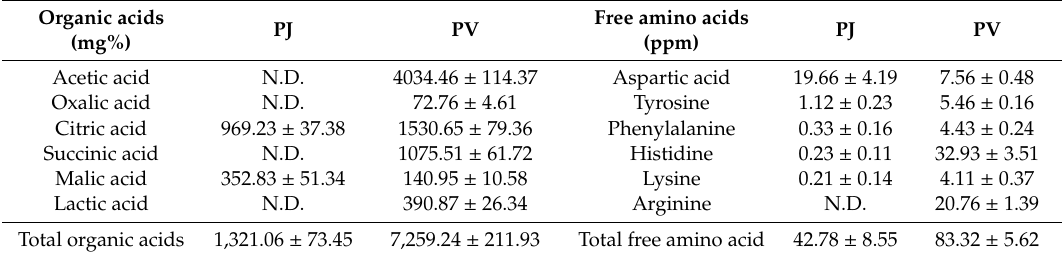
Table 1. Contents of organic acids and free amino acids in Prunus mume vinegar (PV). Organic acids